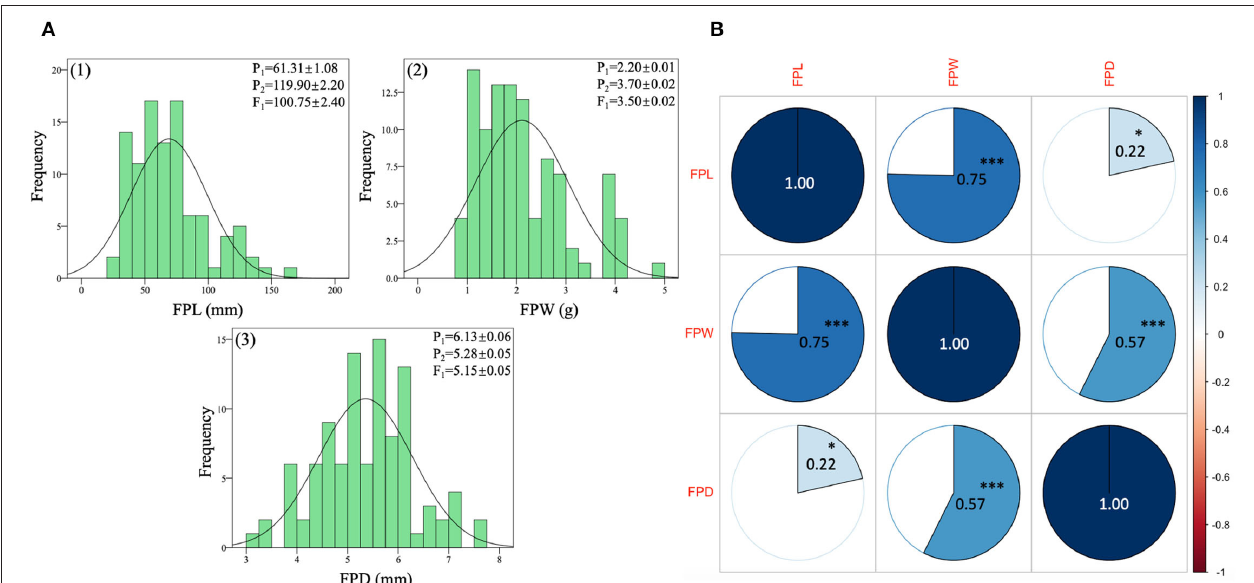
FIGURE 6 | Phenotypic analysis of FP traits of contrasted parent lines, F 1 progeny, and derived F 2 : 3 mapping individuals of watermelon. (A) Histogram of frequency distributions of measured traits. (B) Pearson’s correlation coefficient values of measured traits. The color pie charts and scale bar denote suggestive colinearity at both levels (*** p < 0.01 and * p <